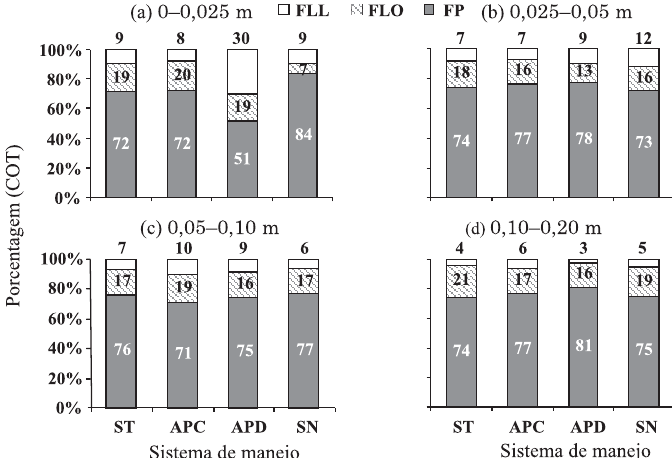
Figura 1. Proporção do carbono orgânico total (COT) nas frações leve livre (FLL), leve oclusa (FLO) e pesada (FP) da matéria orgânica de um Planossolo submetido a diferentes sistemas de cultivo. ST: Sistema tradicional de cultivo: um ano com arroz irrigado por alagamento (preparo convencional), seguido de dois anos de pousio; APC: Sistema de cultivo contínuo de arroz irrigado por alagamento (preparo convencional); APD: Sucessão de azevém x arroz irrigado por alagamento (plantio direto); e SN: Solo sob vegetação nativa (sem cultivo).